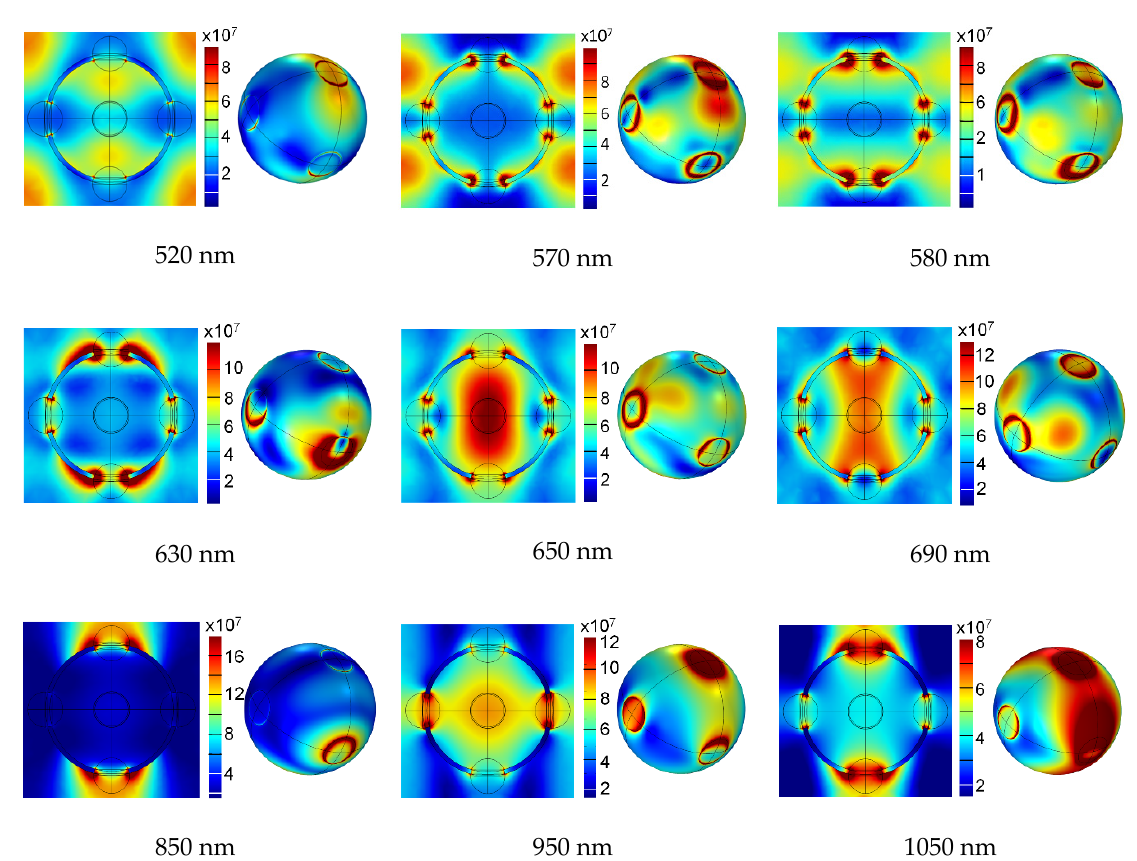
Figure 13. Spatial distribution of electric field in a unit cell of planar square lattice of simple brochosome-inspired plasmonic particles ( left part of each sub-picture ) and the field on the surface of a single brochosome-inspired particle ( right part ). The design data are the same as in Figures 11 and 12. The operating wavelengths for each case are given below the corresponding sub-picture.